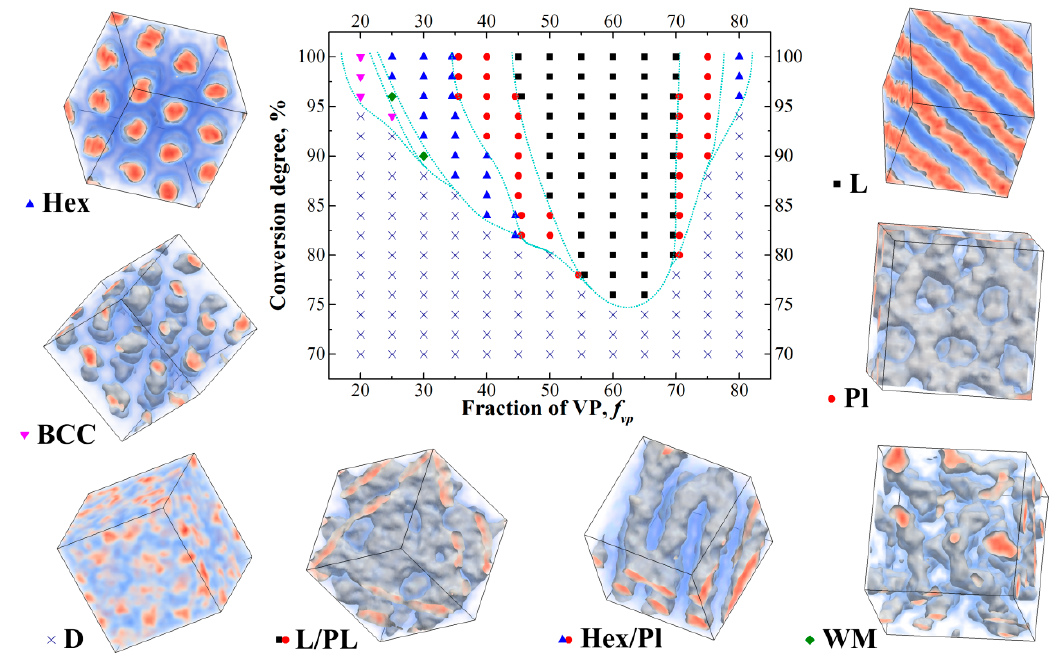
Figure 2. Obtained phase diagram during controlled copolymerization of S and VP in bulk. The observed structures are: D—disordered, L—lamellar, PL—perforated lamellae, Hex—hexagonally packed cylinders, S—body ‐ centered cubic structure, WM [45]—wormlike micelles. Two types of transitional structures were observed: Hex/Pl and L/Pl. The first one is hexagonally packed cylinders, some of which are connected to each other by rare bridges; the second one is lamellae with some number of perforations, which appear to have no order within every layer.